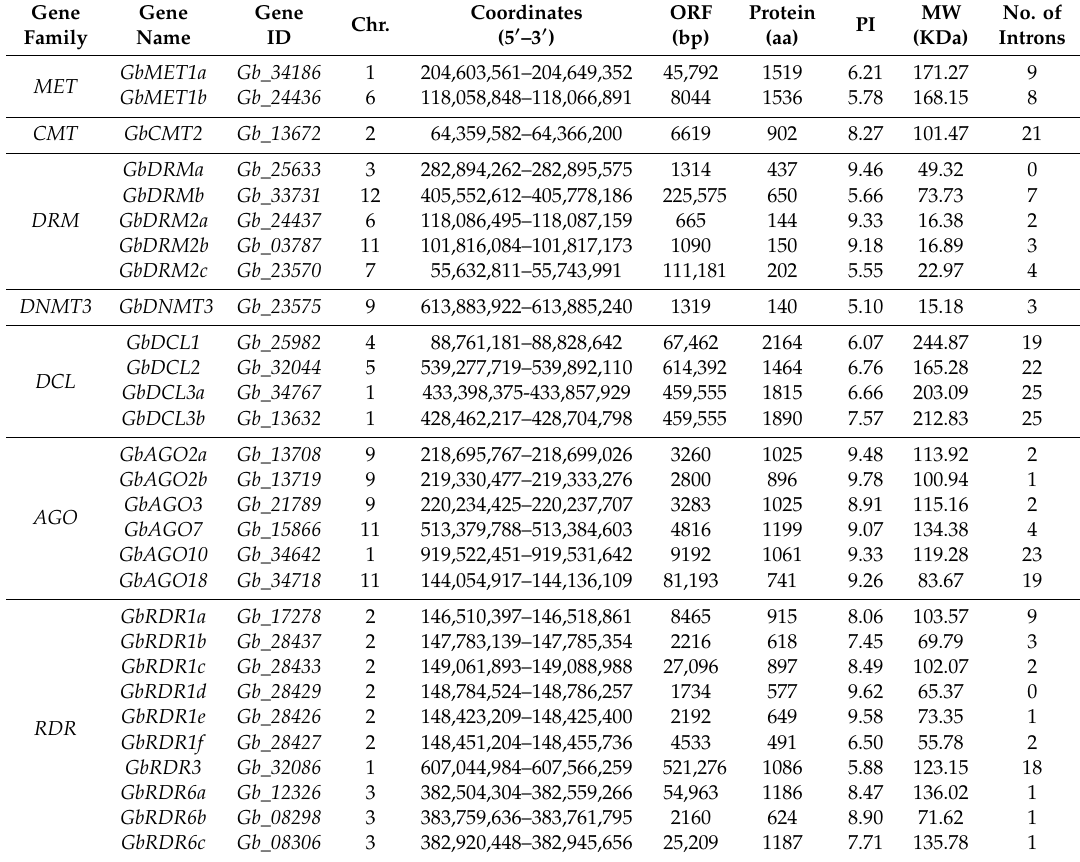
Table 1. Identification and structural analysis of DNA methylation pathway